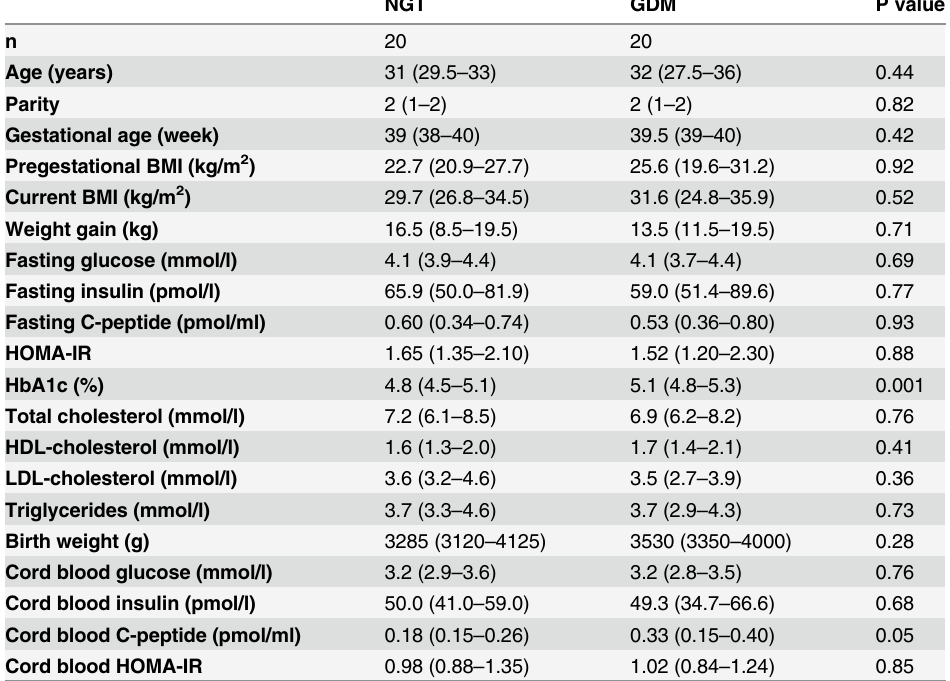
Data are shown as medians (interquartile range), NGT, normal glucose tolerance, GDM, gestational diabetes mellitus, differences between NGT and GDM groups were analyzed by Mann-Whitney U